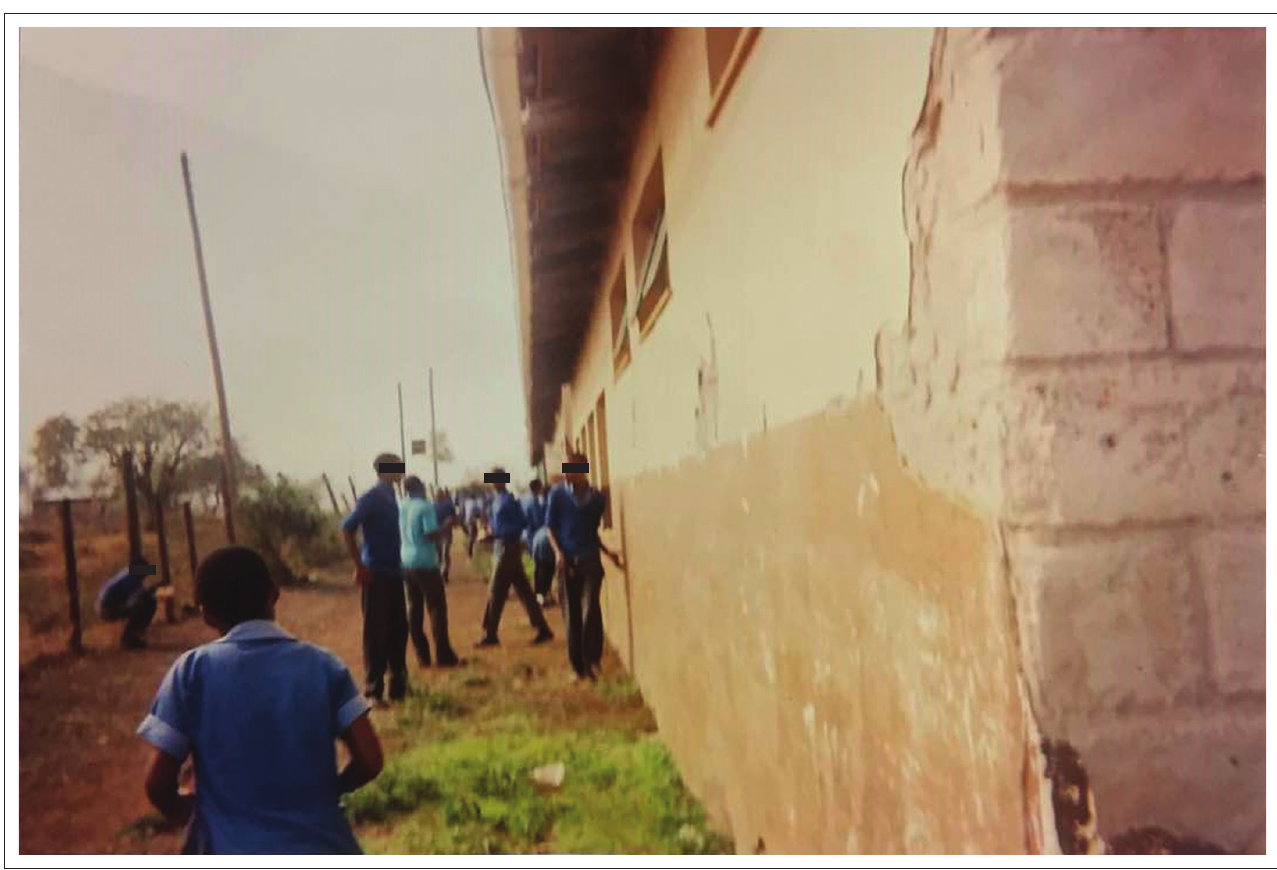
FIGURE 1: This picture shows boys playing behind the classrooms. Cmash claimed that these were the dominant boys in the school – boys with heterosexual